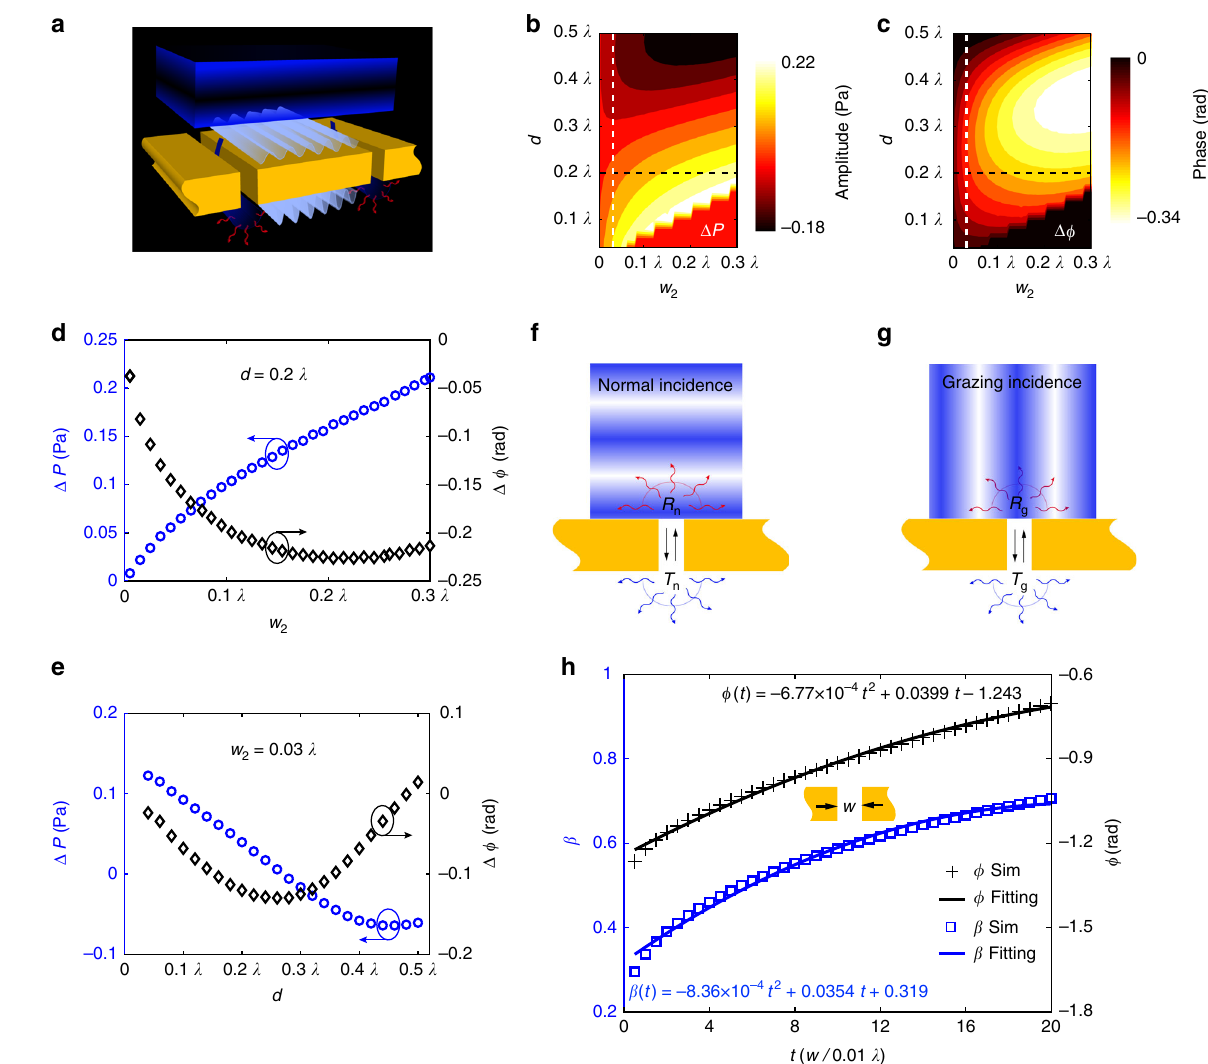
Fig. 2 Microscopic coupled-wave model. a The wave dynamics on the slit-doublet con fi guration. The incident wave scattered by a slit can be regarded as a new point source which then generates a cylindrical wave (CW). The CWs on the surface are partially funneled into the other slit, as well as scattered by it. The scattered and funneled waves again excite the CWs. The processes of scattering and funneling are repeated until the CWs are diminished. For clarity, only one iteration process is depicted. b , c The changes of amplitude ( Δ P ) and phase ( Δ ϕ ) at the exit of the reference slit affected by the width w of adjacent slit and the distance d between them. d The pro fi les of Δ P and Δ ϕ as a function of slit width along the black dashes ( d = 0.2 λ ) in Fig. 2b, c. e The pro fi les of Δ P and Δ ϕ as a function of separation distance along the white dashes ( w 2 = 0.03 λ ) in Fig. 2b, c. f , g The transmission and re fl ection coef fi cients of a subwavelength slit for normal and grazing incidences. h The dependence of the characteristic parameters ( β , ϕ ) of the CW on the slit width. They are fi tted as a polynomial function using the least-mean-square method. The slit width is scaled in the fi tting, i.e., t = w /0.01 λ . The source data underlying Fig. 2h are provided as a Source Data fi